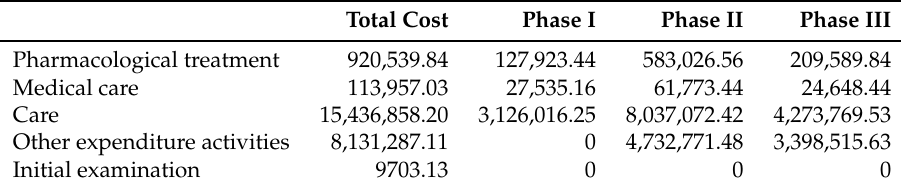
Table 6. ABC; cost resource pools in e .